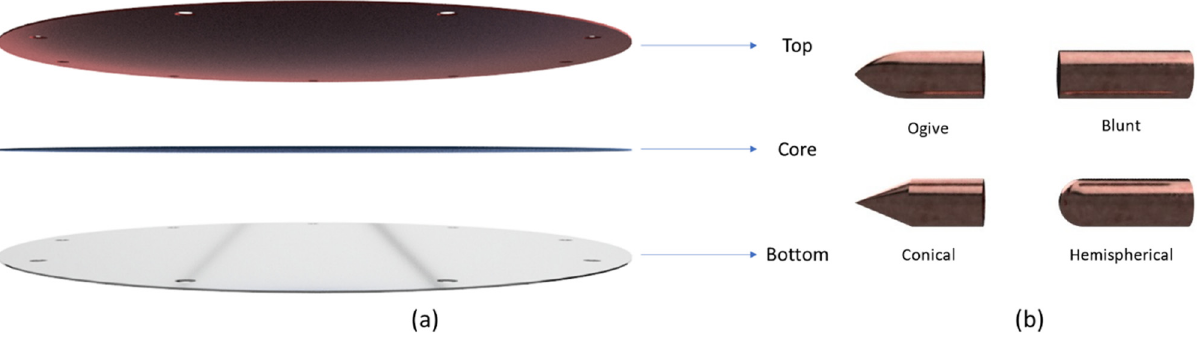
Figure 6: Numerical modeling: ( a ) plate target layers and ( b ) bullet shapes variation.